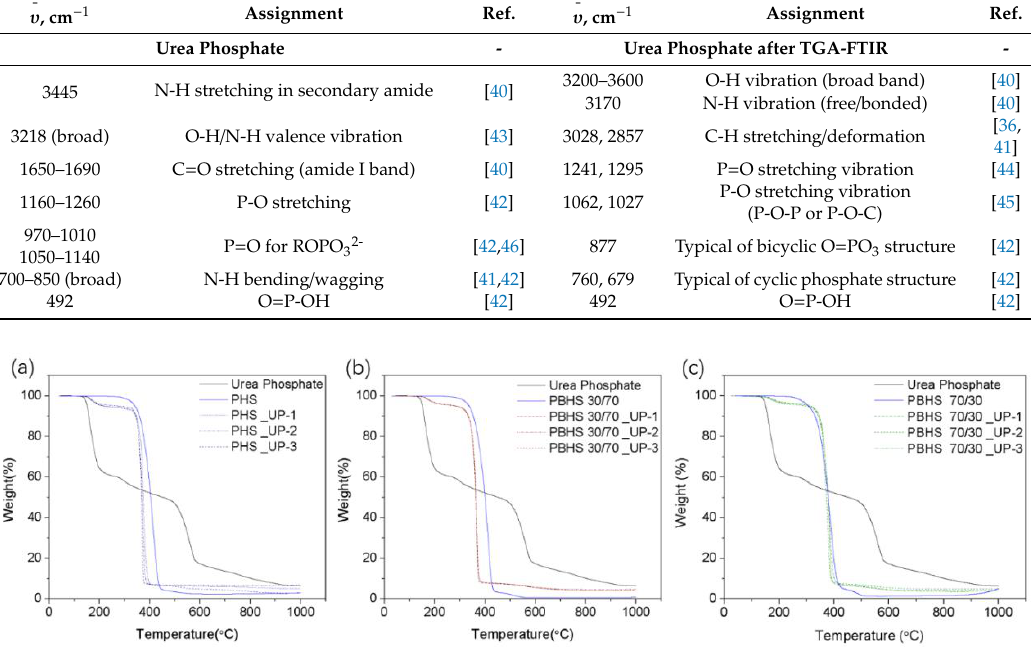
Figure 4. TGA of neat polymer, urea phosphate with ( a ) PHS_UP blends, ( b ) PBHS 30 / 70_UP blends,